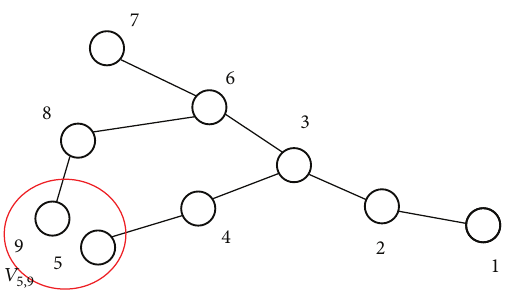
Figure 3: A coarse-grained model with monomers 5 and 9 interact- ing with the second virial coefficient 𝑉 5,9